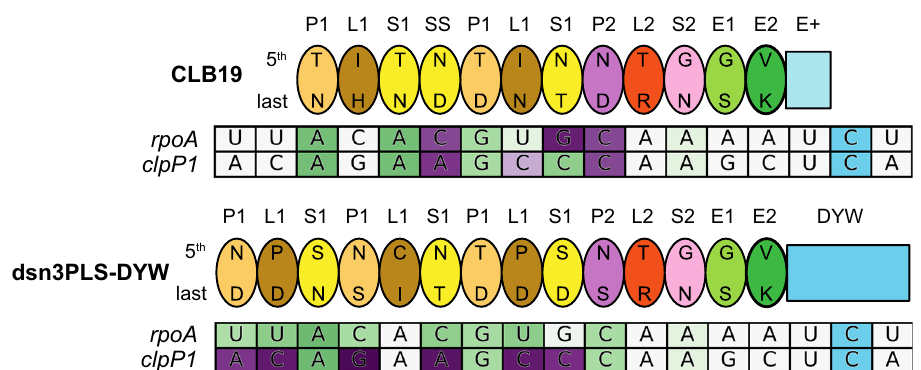
Fig. 1 Schematic representation of CLB19 and dsnPLS-DYW bound to their target sites. The proteins are represented by ovals for each PPR motif including the 5th and last speci fi city-determining amino acids. The target sites are coloured according to the predicted favourability of the alignment at each position, from favoured (green) to neutral (white) to disfavoured (purple). These values are taken from ref. 26 . The C at the editing site is shaded